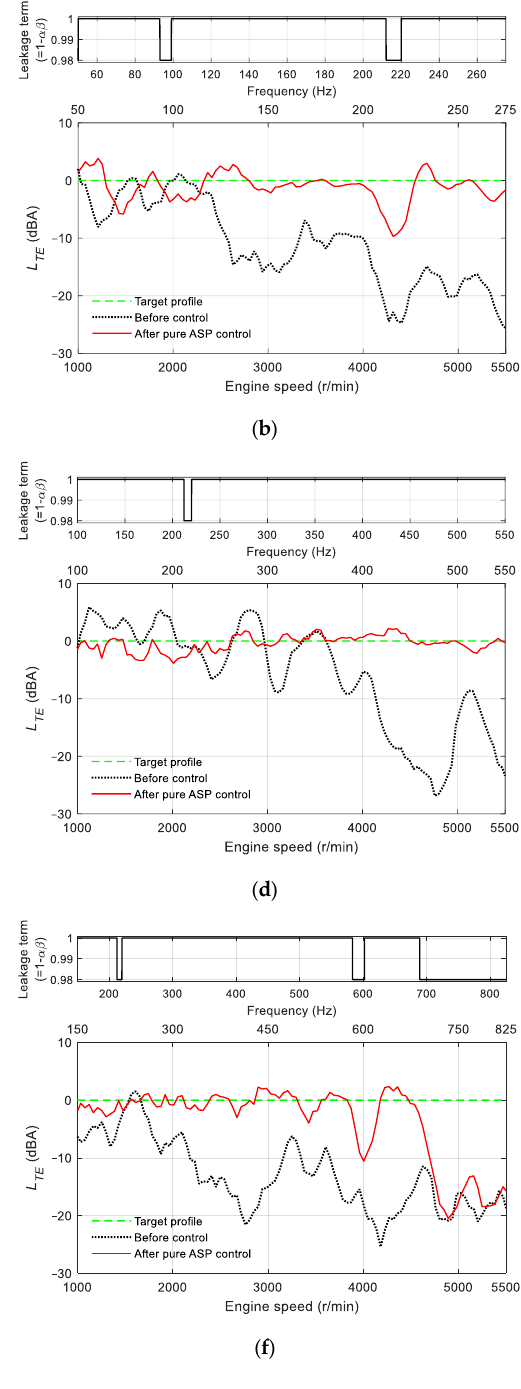
Figure 8. Comparisons of the measured SPL of each order before and after the pure ASP control, and the tracking errors between the measured SPLs and the target profiles. ( a ) SPL of the C3 order. ( b ) Tracking error of the C3 order. ( c ) SPL of the C6 order. ( d ) Tracking error of the C6 order. ( e ) SPL of the C9 order. ( f ) Tracking error of the C9